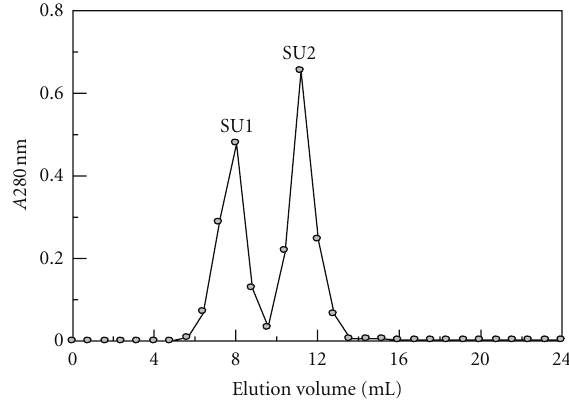
Figure 2: FPLC-gel filtration on Superdex 75 HR 10/30 column. Sample: fraction CM2. Eluent: 0.2 M NH 4 HCO 3 bu ff er (pH 8.5). Fraction size: 0.8 mL. Flow rate: 0.4